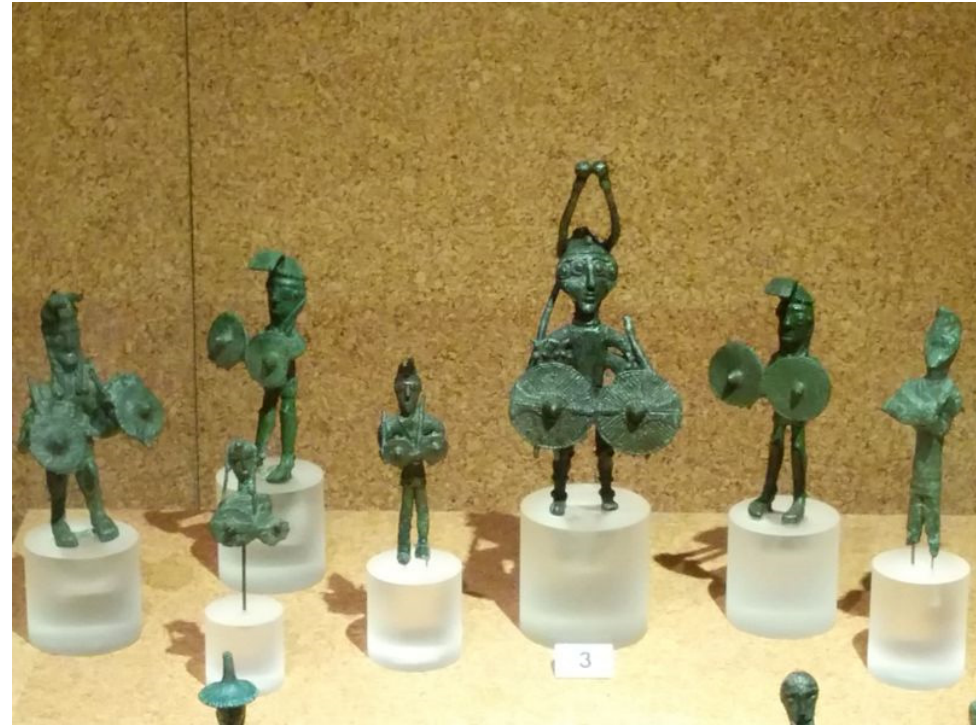
Figure 4. Nuragic bronze figures (‘Bronze statuettes of nuragic civilisation at Cagliari Museum’ by Prc90 2014/Wikimedia Commons is released under CC BY-SA 3.0).